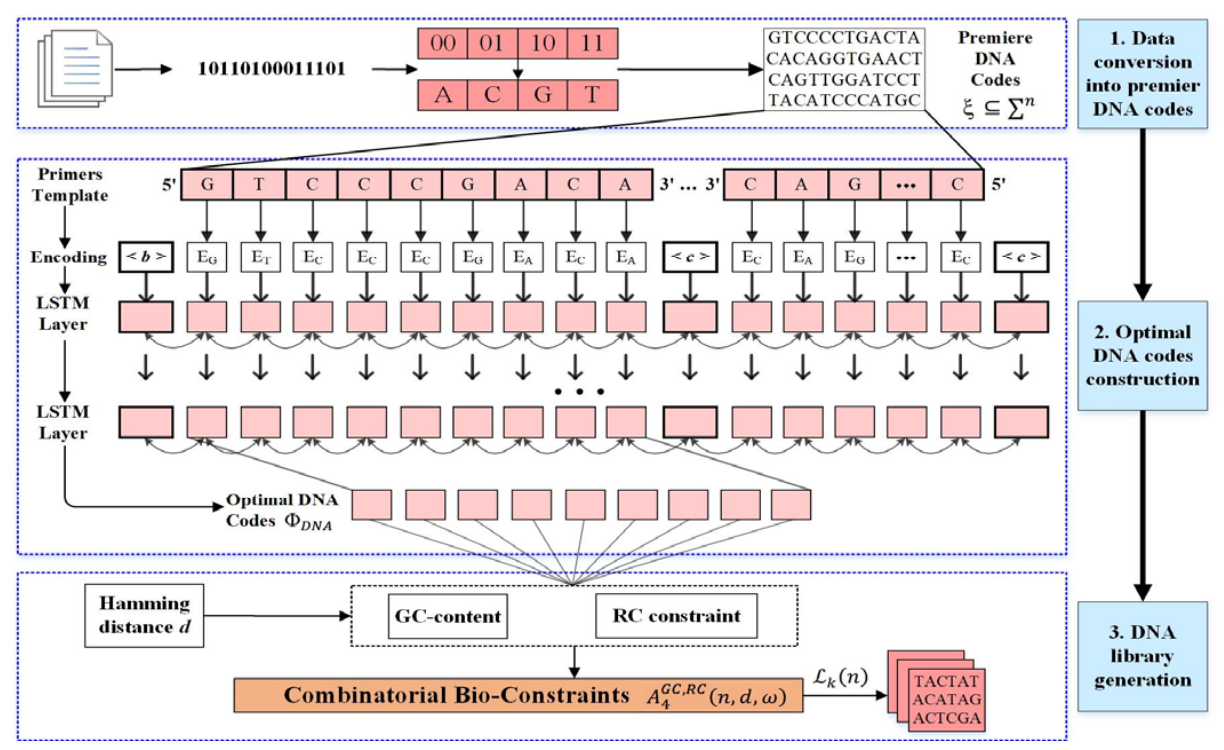
Figure 1. The proposed computational model with NN and combinatorial bio ‐ constraints for DNA data storage.